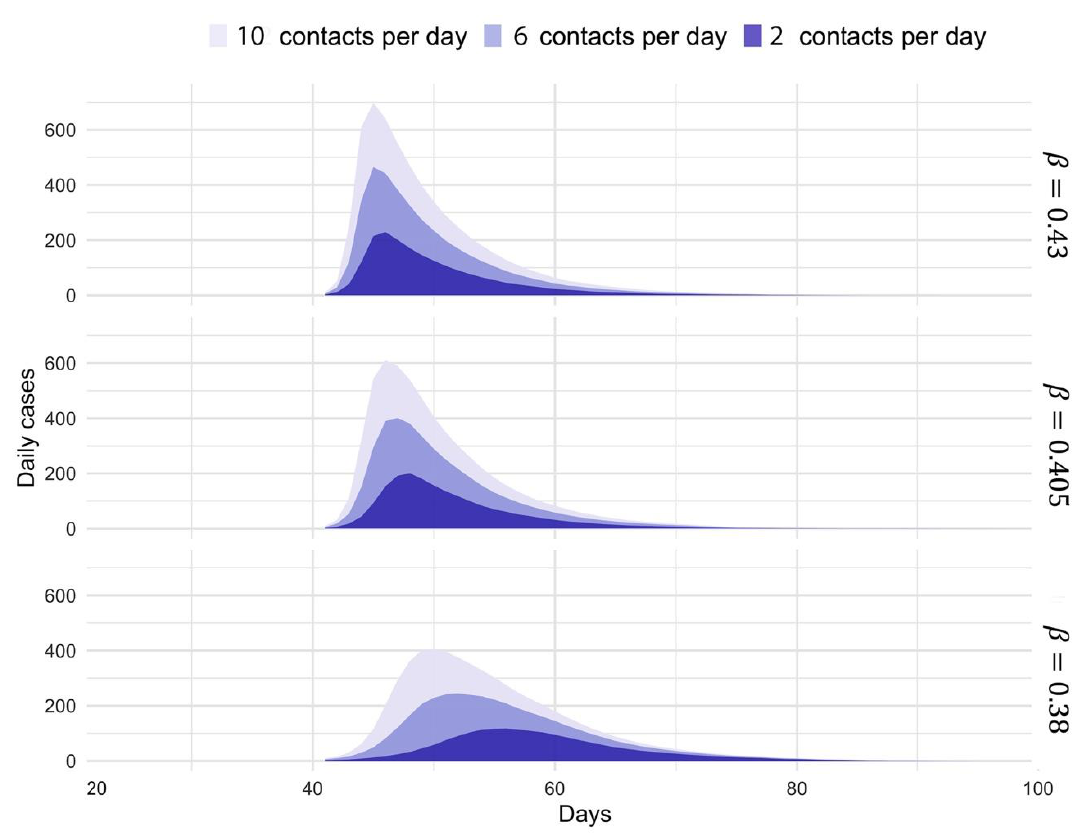
Figure 8. Stochastic simulation results of SIR model with various infection rates and contacts after the repatriation plan.